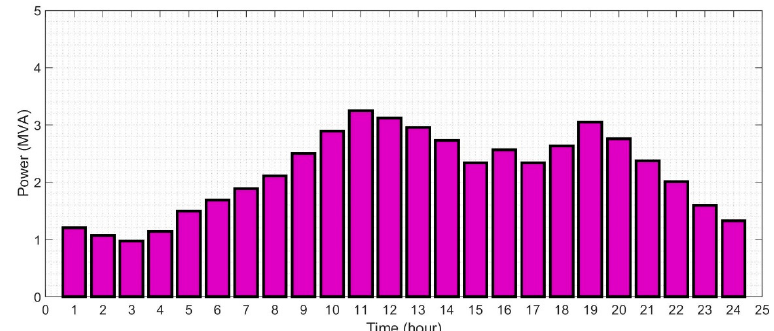
Figure 6. The curve of demand for one day.